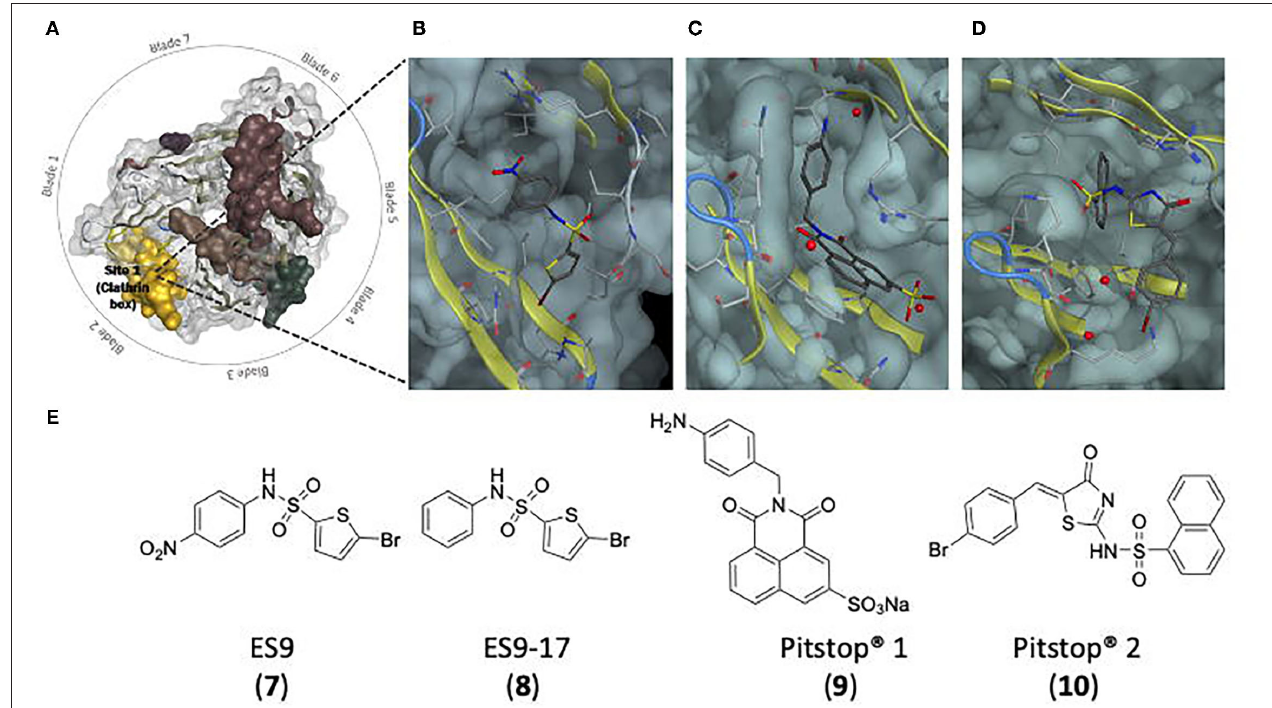
FIGURE 8 | Binding site and structures of small molecule clathrin inhibitors. (A) Top view of the CTD, showing Site 1 (in yellow) the binding site of ES9 ( 7 ), ES9-17 ( 8 ), Pitstop® 1 ( 9 ), and Pitstop® 2 ( 10 ) ( Ter Haar et al., 1998). (B) ES9 in site 1 of the CTD (Dejonghe et al., 2019). (C) Pitstop® 1 in site 1 of the CTD. (D) Pitstop® 2 in site 1 of the CTD (Von Kleist et al., 2011). (E) Chemical structures of ES9 ( 7 ), ES9-17 ( 8 ), Pitstop® 1 ( 9 ), and Pitstop® 2 ( 10 ).